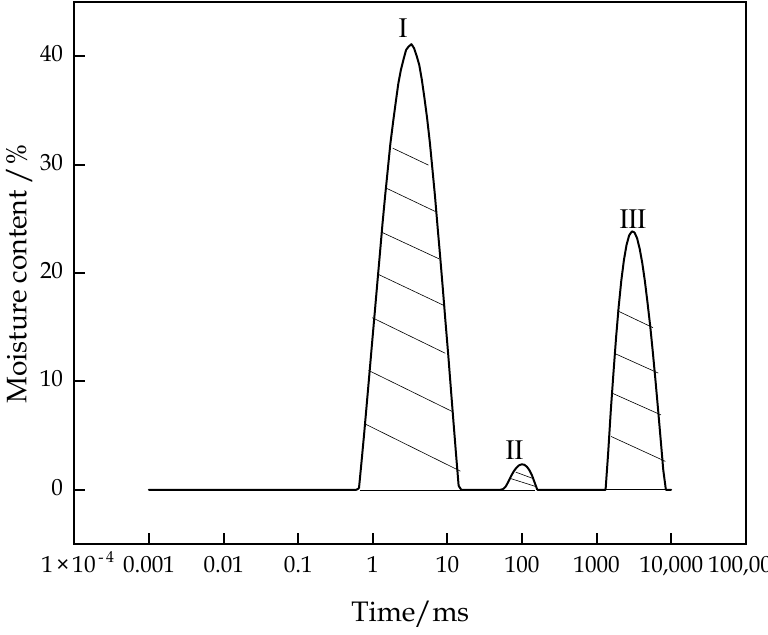
Figure 6. Variation curve of porosity of CFTFS over time.